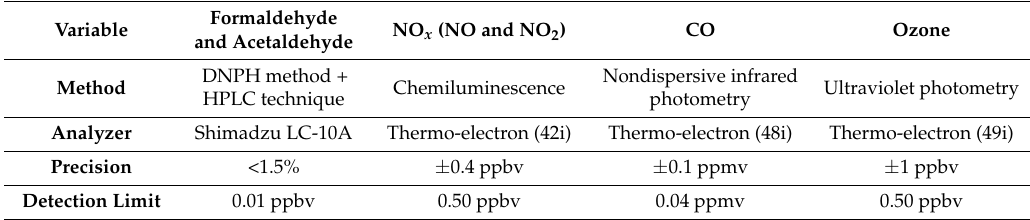
Table 1. Methods and analyzers employed for the measurement of pollutants at the S ã o Paulo State Environmental Protection Agency Pinheiros air quality monitoring station, together with the precision and limit of detection for each